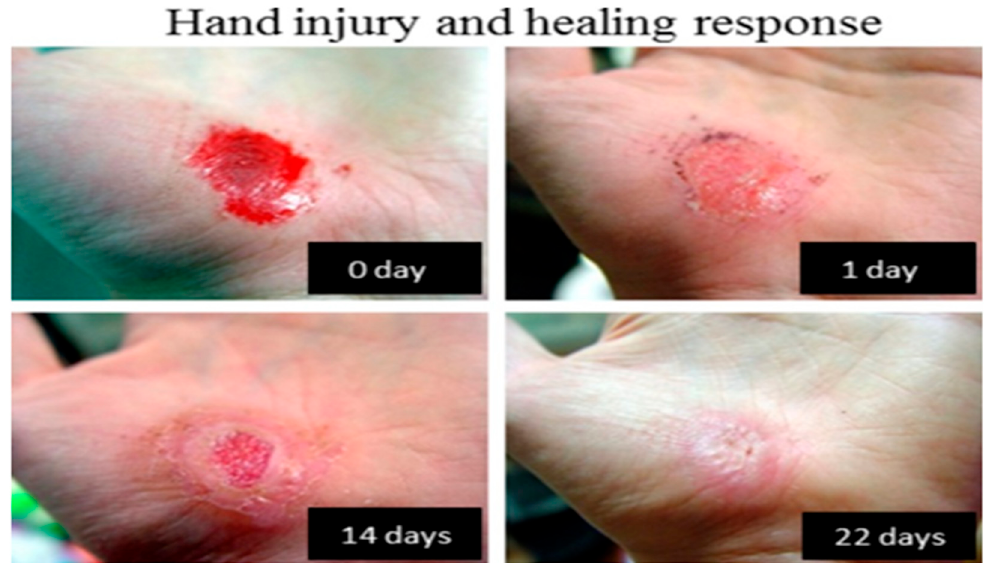
Figure 2. Self-healing mechanism found in nature. (Reprinted with permission from [9]. Copyright Beilstein Journal of Nanotechnology, 2018).